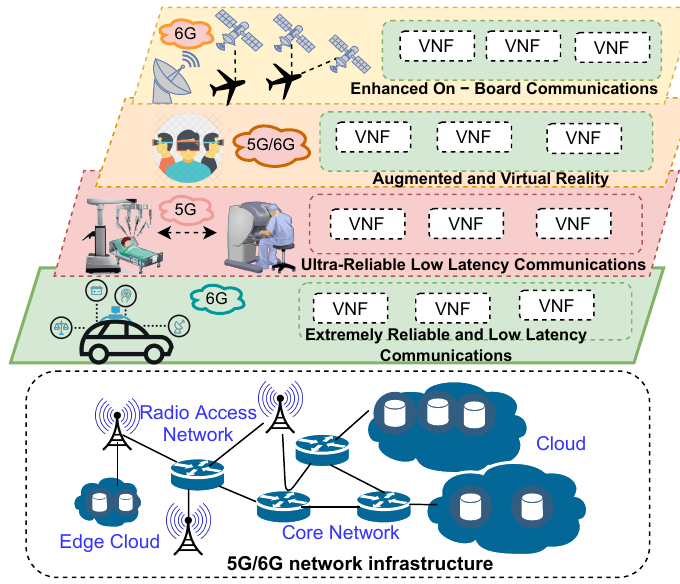
Figure 1. 5G/6G network